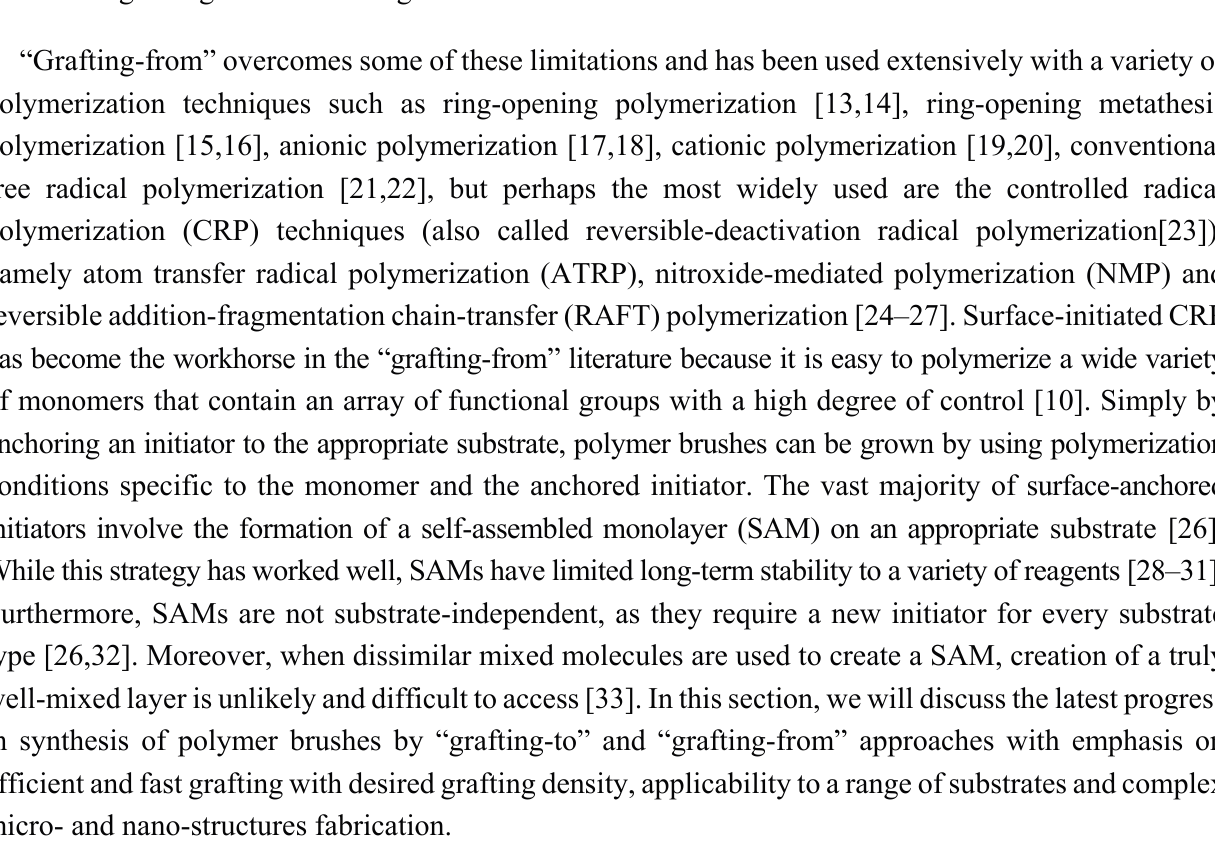
Figure 1. Scheme depicting two strategies to synthesize polymer brushes: “grafting-from” and “grafting-to”